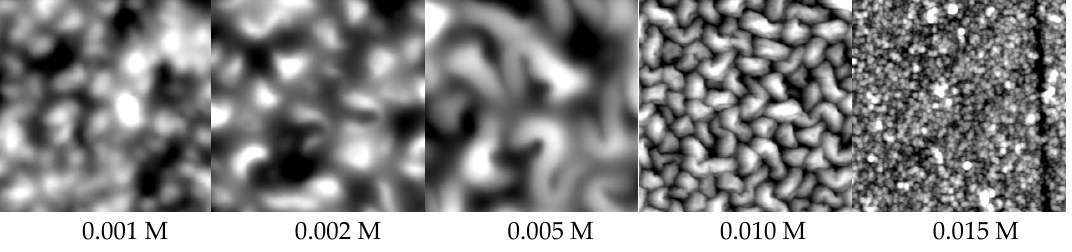
Figure 6. SFM images (topography, 4 × 4 µ m) of PEM-10 of PEI / PAA deposited from solutions at pH Figure 6 . SFM images (topography, 4 × 4 μ m) of PEM-10 of PEI/PAA deposited from solutions at pH 10 / 4 for c PEL = 0.001 M, 0.002 M, 0.005 M, 0.01 M, 0.015 M by the dipping method = 10/4 for c PEL = 0.001 M, 0.002 M, 0.005 M, 0.01 M, 0.015 M by the dipping method (stirring).